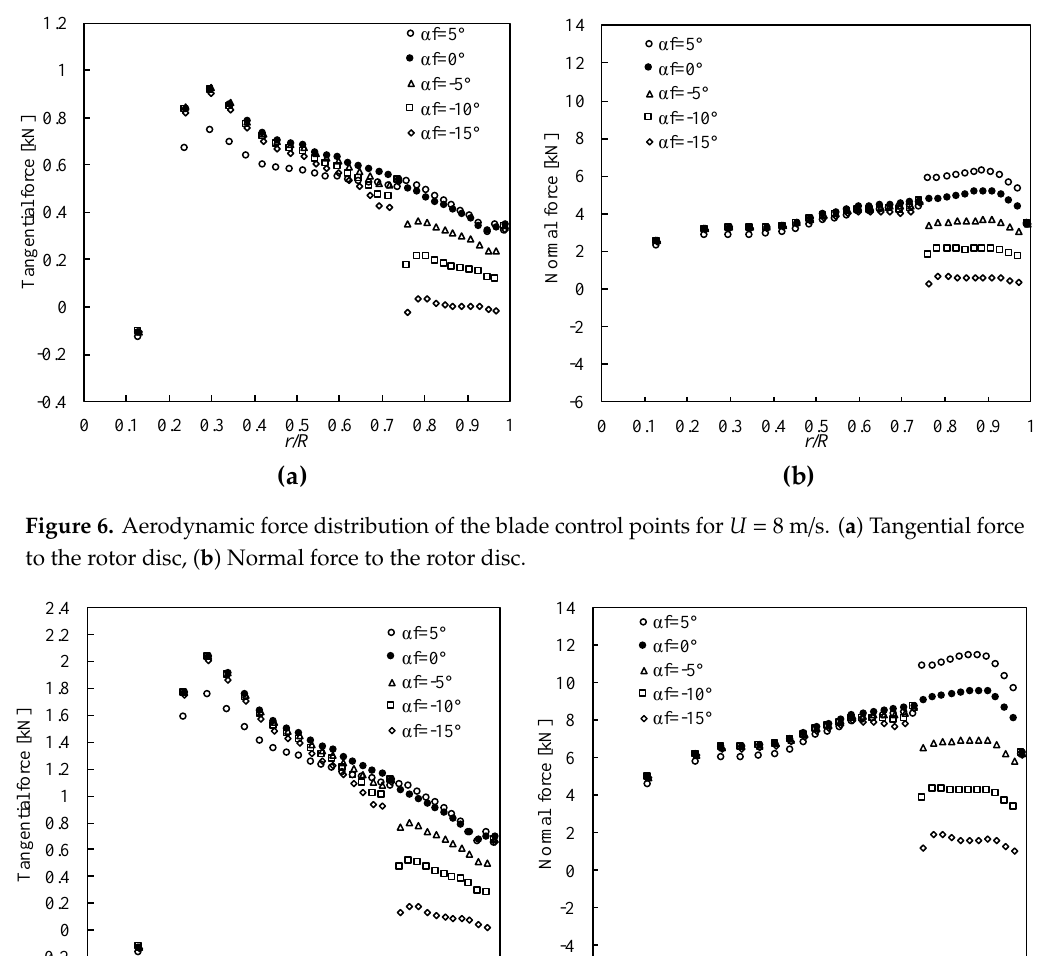
Figure 7. Aerodynamic force distribution of the blade control points for U = 11.4 m/s. ( a ) Tangential force to the rotor disc, ( b ) Normal force to the rotor disc.